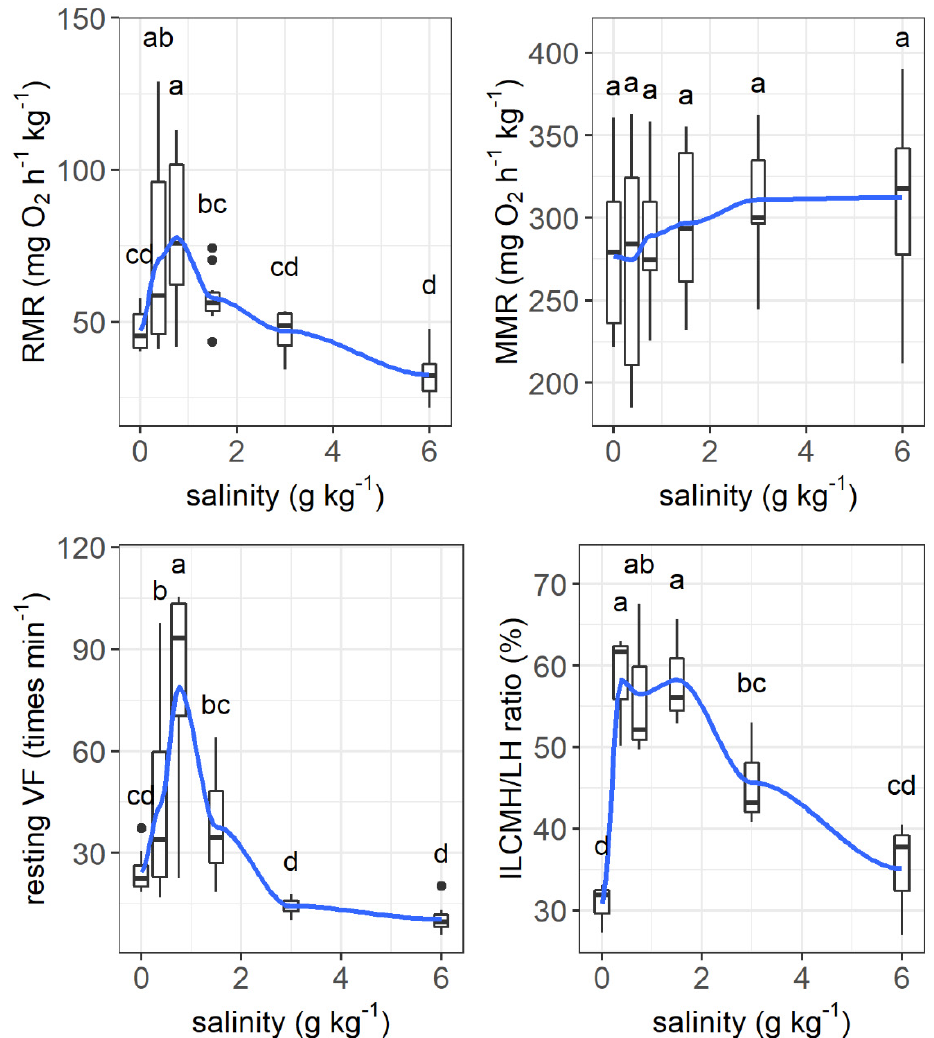
Figure 6. Effects of salinity on the resting metabolic rate (RMR, mg O 2 h − 1 kg − 1 ), maximum metabolic rate (MMR, mg O 2 h − 1 kg − 1 ), ventilation frequency (times min − 1 ), and the ratio of interlamellar cell mass height to lamellar height (ILCH/LH ratio) of grass carp. The data are expressed as boxplots, with boxes indicating the upper, middle, and lower quartiles, and vertical lines indicating the upper whisker and lower whisker. The blue curve describes the changing tendency using locally weighted scatterplot smoothing (LOWESS). a–d: Boxes without common superscripts indicate significant differences among treatments ( p < 0.05). Black dot: the outliers.